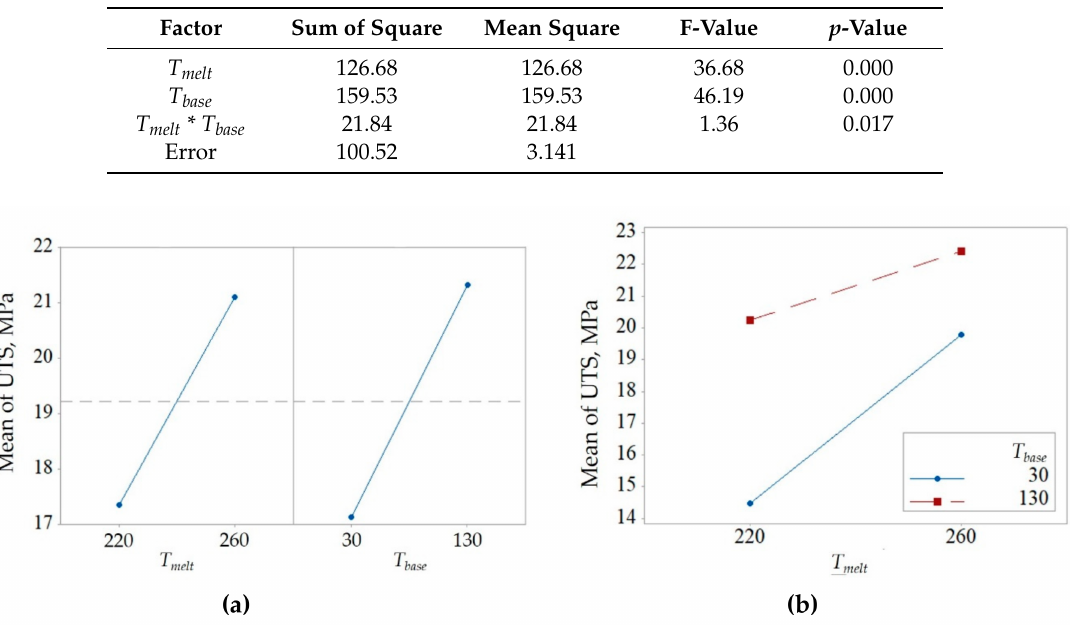
Figure 4. ( a ) Main e ff ects and ( b ) interaction plots for the melt temperature and base